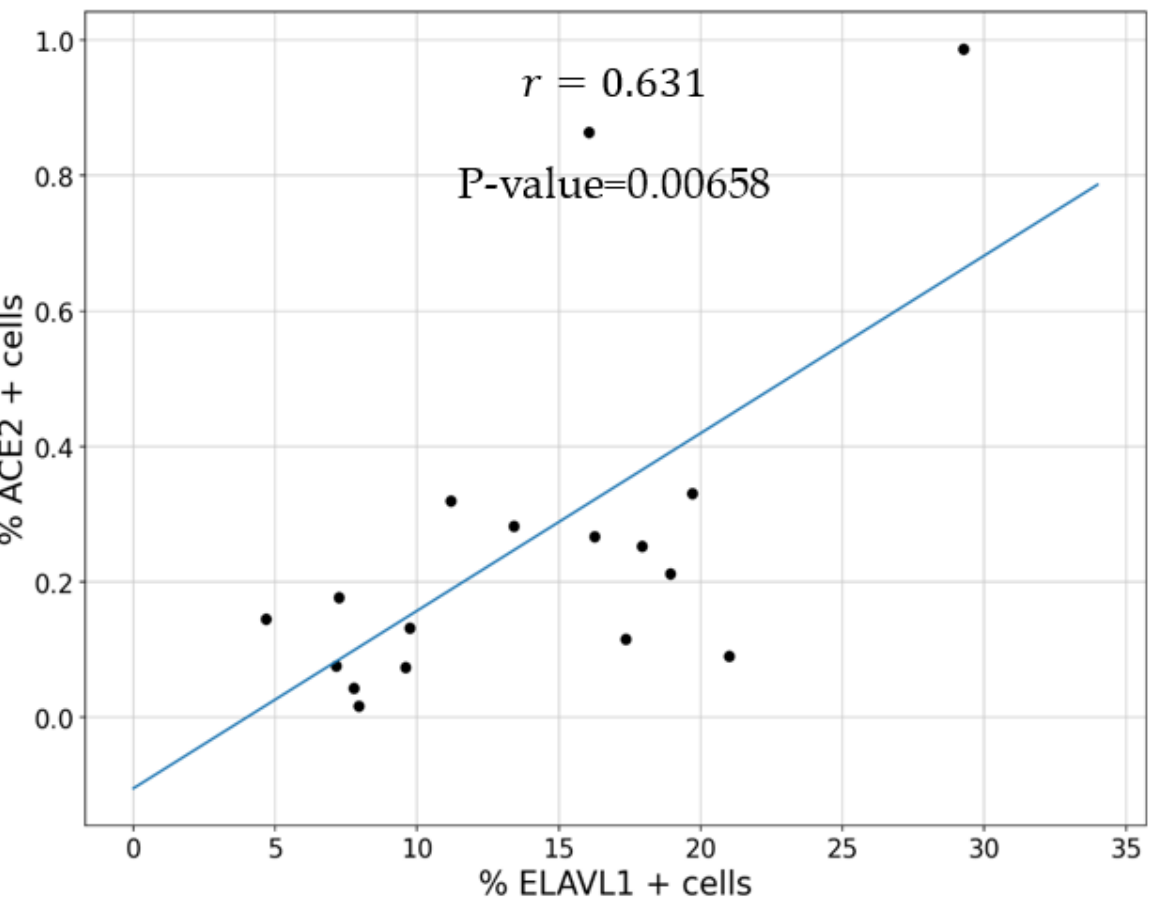
Figure 3. Correlation between ELAVL1 and ACE2 in COPD. The percentage of ELAVL1 and ACE2 positive cells in all cell types of the COPD samples were analyzed. There was a significant ( p -value < 0.01) correlation (Pearson correlation coefficient = 0.631) between ELAVL1 and ACE2 . Only cell types expressing both ELAVL1 and ACE2 were included in the analysis.